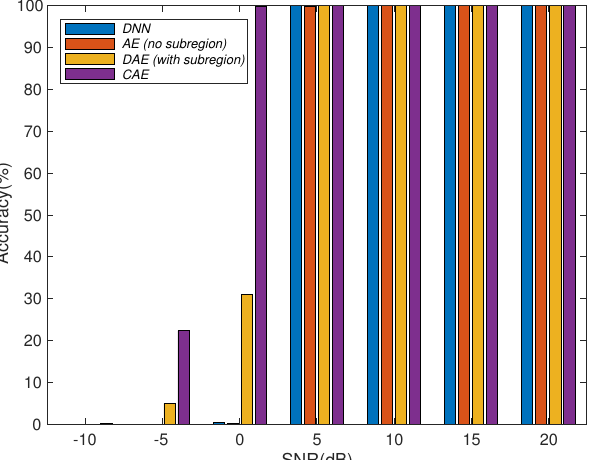
Figure 7. Comparison of accuracy with different deep learning methods for DOA